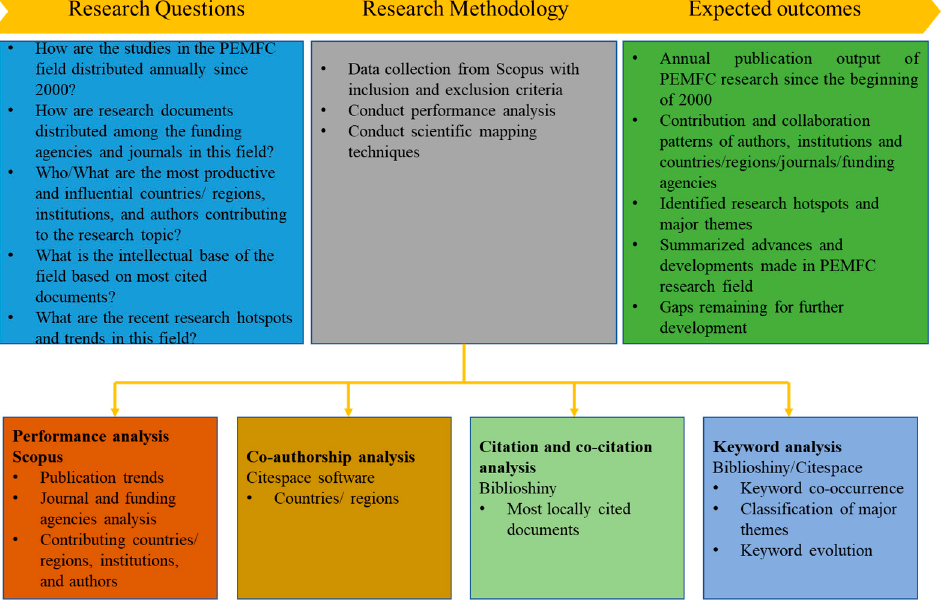
Figure 12. Conceptual framework of the present study.